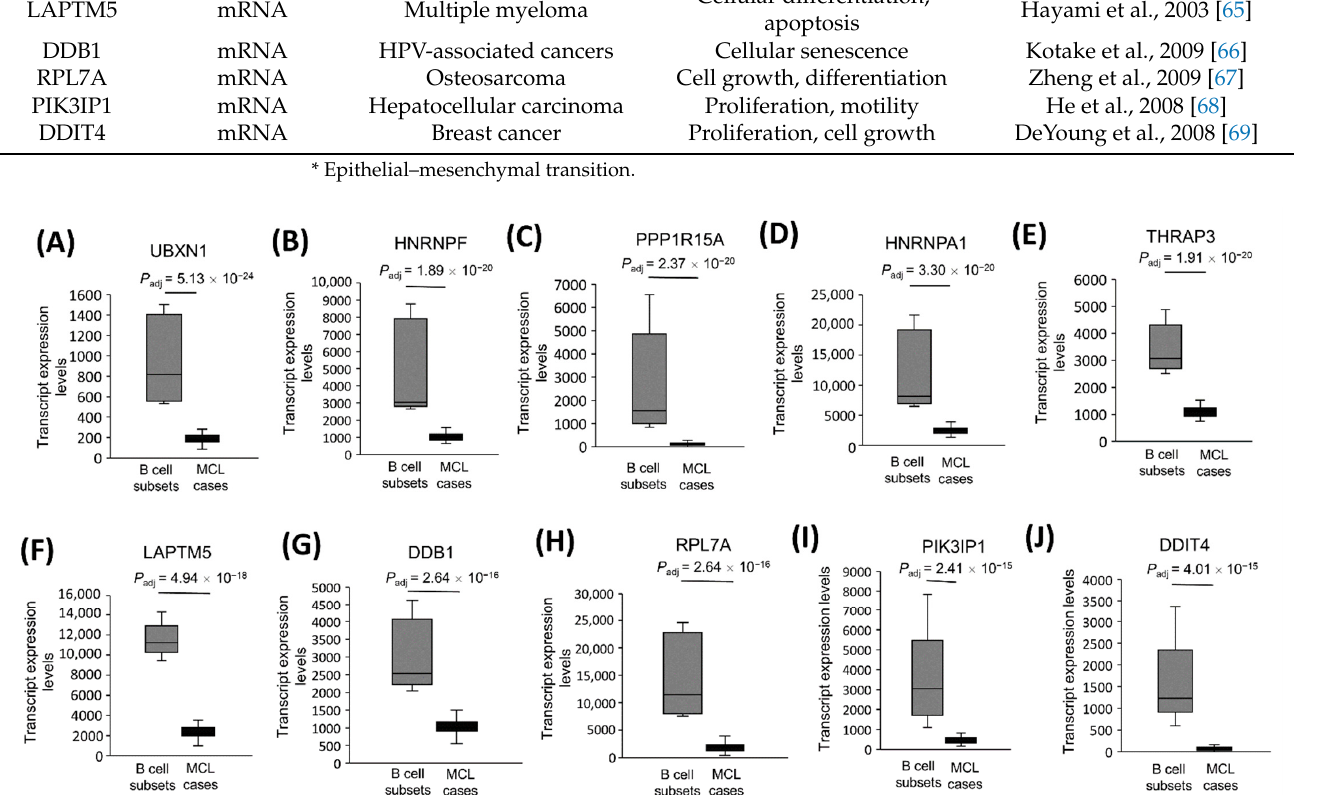
Table 3. List of the top 10 overexpressed oncogene-candidate lncRNAs in MCL cases.